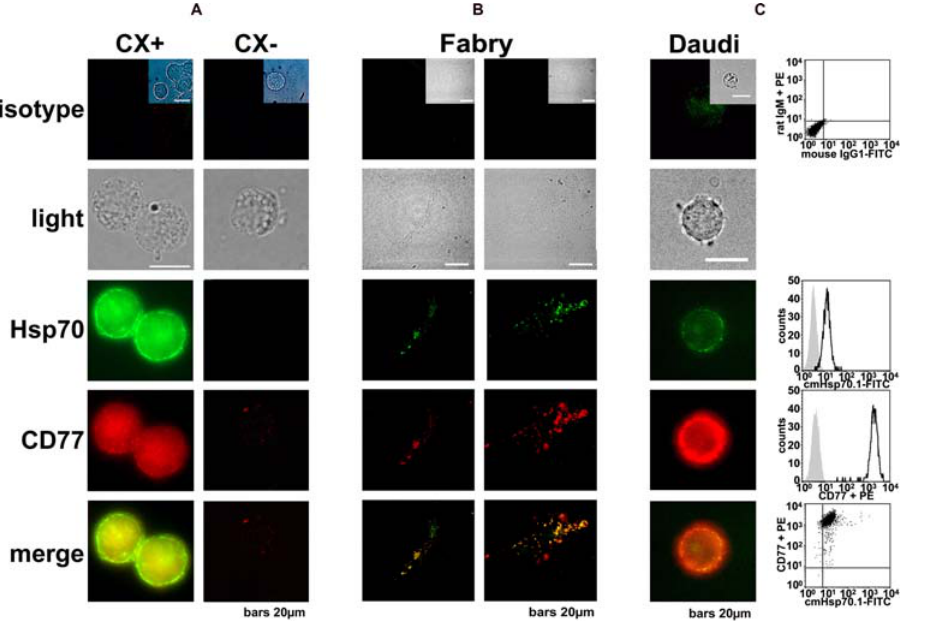
Figure 4. Bright field and fluorescence microscopic analysis of CX + and CX 2 tumor sublines (A), Fabry fibroblasts (B), and Daudi Burkitt’s lymphoma cells (C). Cells were stained either with a relevant isotype-matched control antibody (isotype) or with an Hsp70 (cmHsp70.1- FITC, green) or Gb3 (CD77 plus Cy3-conjugated secondary antibody, red) specific antibody. The co-localization of Hsp70 and Gb3 is visualized in yellow as a merge of red and green in the lowest panel. Scale bar marks 20 m m. In comparison to CX + and Fabry cells, the density of Gb3 on the cell membrane of Daudi cells is markedly increased, as indicated by a high mean fluorescence intensity of the CD77 staining. A double stain of Hsp70- FITC and Gb3-Cy3 indicates co-localization of both markers on the cell surface (lower right graph). Similar findings were obtained in experiments using the Colo + /Colo 2 tumor sublines (data not shown). On the right hand panel of Figure 4C, representative flow cytometric profiles of Daudi cells are shown; the upper graph represents the double staining pattern of the isotype-matched antibodies IgM-PE and IgG1-FITC; the graphs below show single staining of Daudi cells with Hsp70-FITC (second graph) and CD77-PE (third graph). The fourth graph represents the double-staining pattern of Daudi cells using Hsp70-FITC and CD77-PE